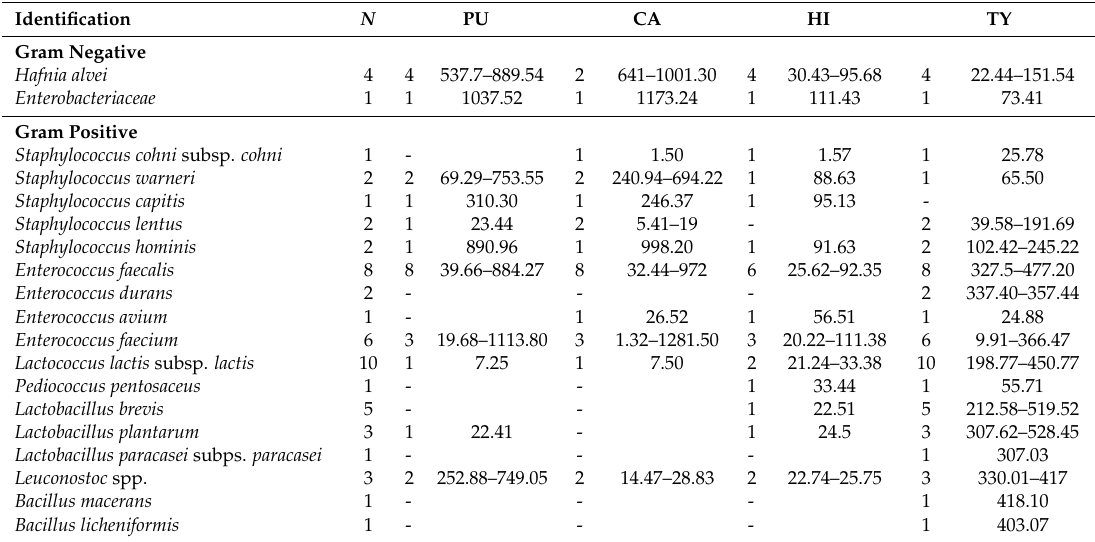
Table 5. Identification of strains obtained from goat’s raw milk cheeses with decarboxylase activity and their BA production in decarboxylase broths (mg/mL). Results are shown without considering the HHP treatments to which some cheese samples were